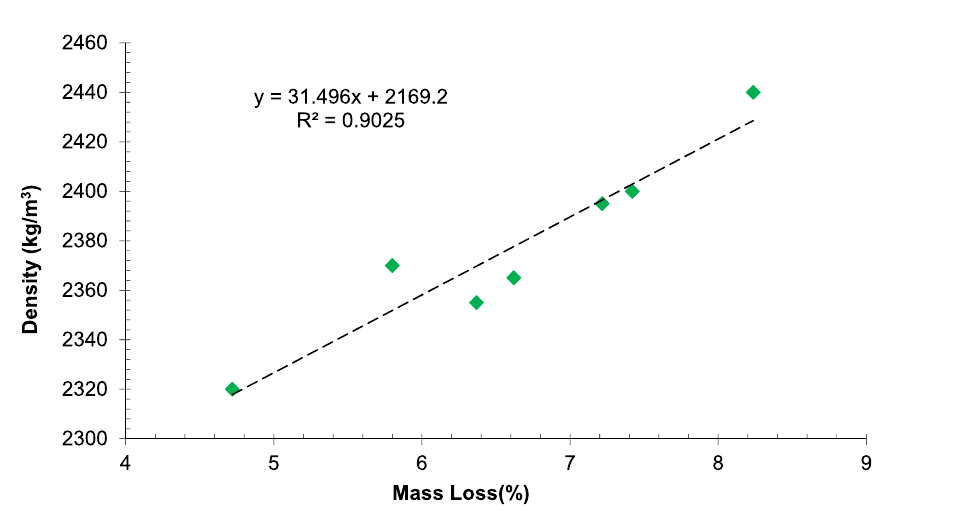
Figure 18. Correlation between density and acid